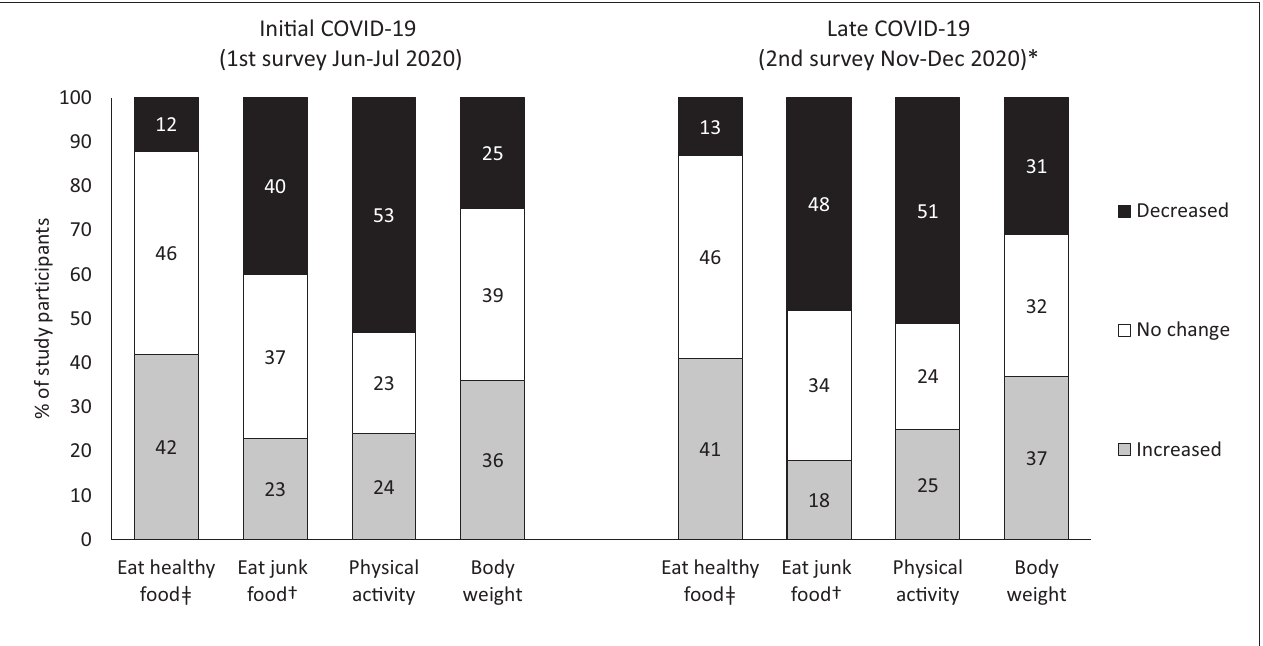
FIGURE 1 | Perceived changes in diet, physical activity and body weight, between pre-pandemic to initial and later stages of COVID-19 pandemic (1st and 2nd survey round). *Weighted to maintain the distribution of sociodemographic variables of 1st round’s participants. ‡ Fruit, vegetables, whole grains, legumes, plain water. †Chips, sodas, cookies,